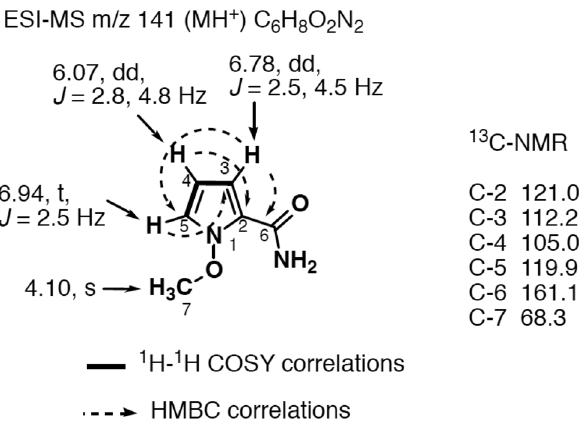
Figure 1. Structure of kumamonamide and its NMR